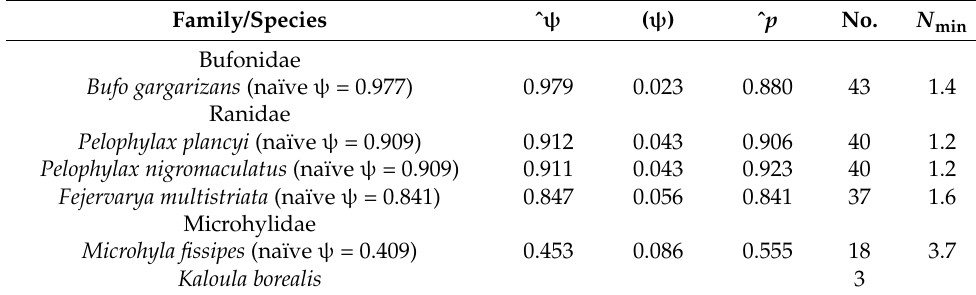
Table 2. Summary results of the estimated probability of occupancy, detection probabilities under constant probability of occupancy and